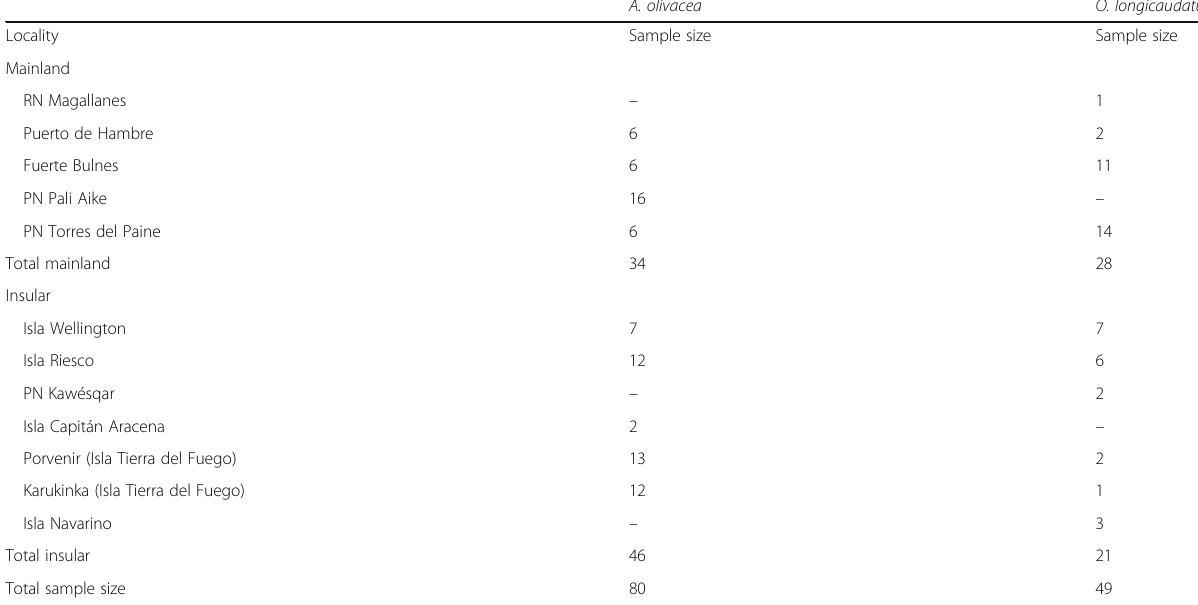
Table 1 Sample size and localities assessed in this study for A. olivacea and O. longicaudatus in the Chilean southern Patagonia. All localities are grouped by precedence, i.e., mainland or island A. olivacea O. longicaudatus Sample size Sample